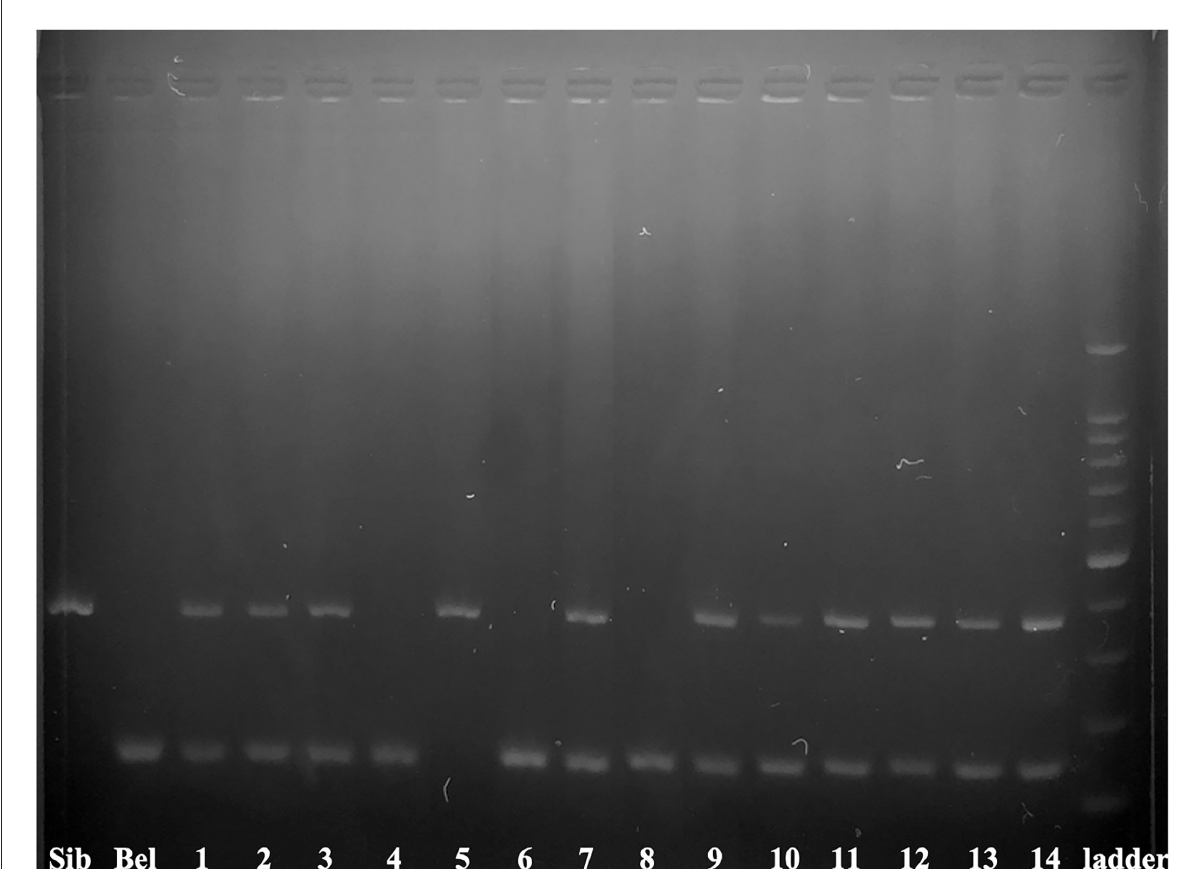
FIGURE1 Electrophoretogram of 395_AB and 153_HH markers in 14 ICSI produced embryos. The marker 395_AB amplifies 395 bp band only when the sample contains Siberian and/or Russian sturgeon nuclear DNA while the marker 153_HH amplifies 153 bp band only when a sample contains nuclear DNA of beluga. Numbers correspond to the embryos and larvae of Table 2. Siberian sturgeon fin (Sib) and beluga fin (Bel) are used as positive controls 100–1500 bp